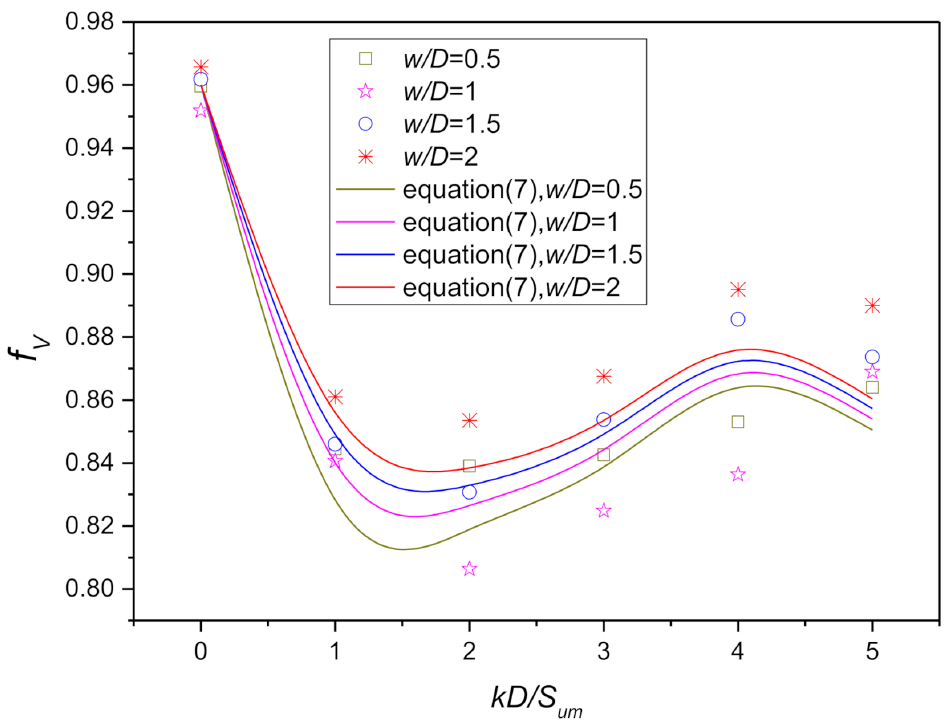
Figure 23. Reduction factors of vertical dimensionless elastic stiffness coefficients related to kD and w . D